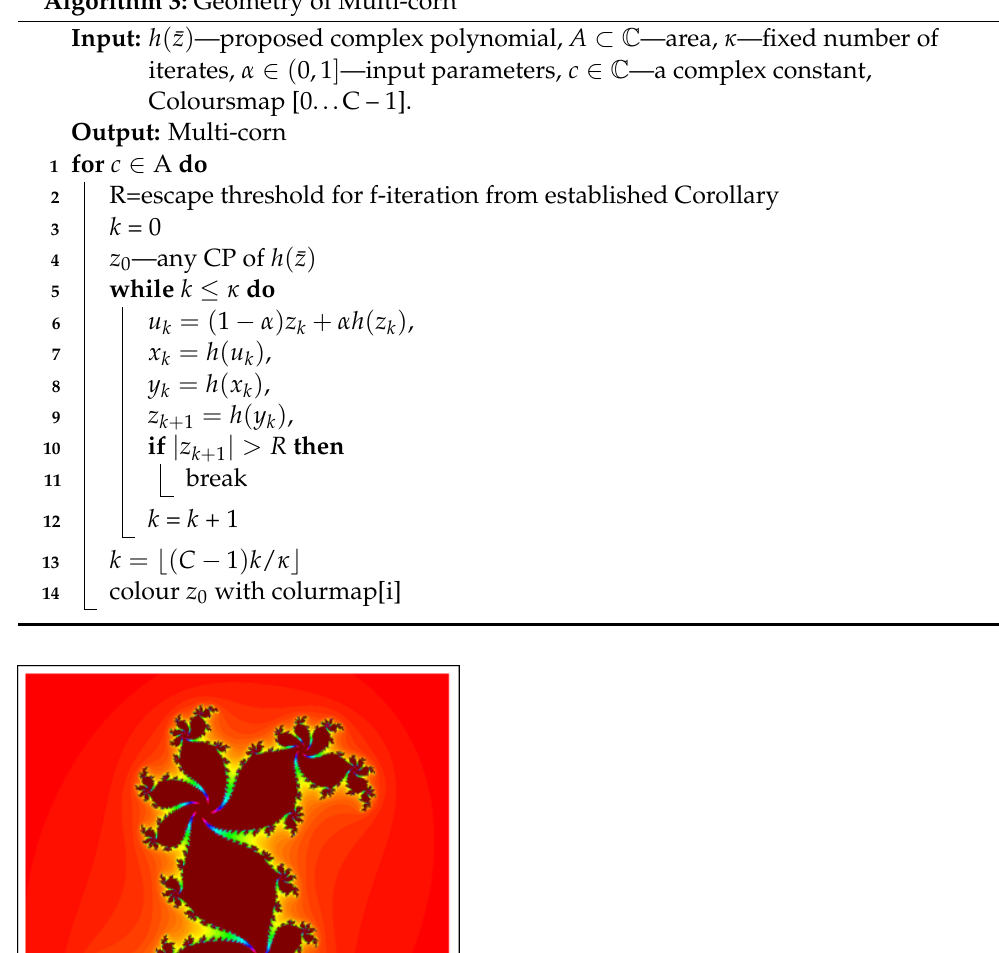
Algorithm 3: Geometry of Multi-corn